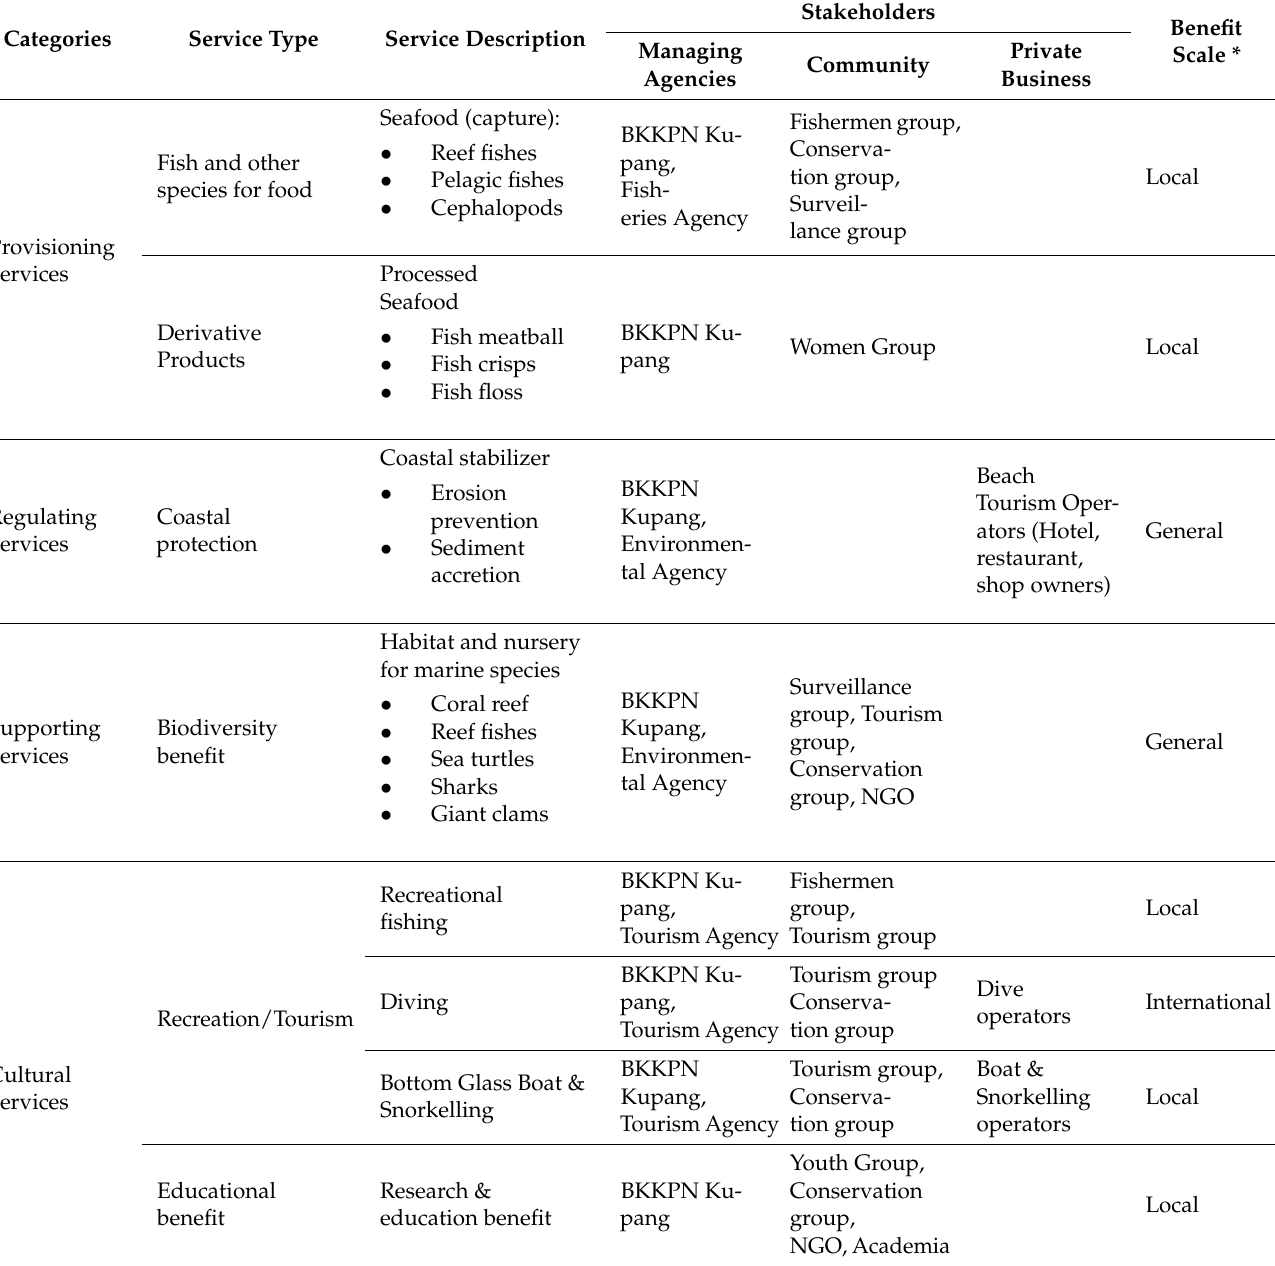
Table 1. The Ecosystem Services and Stakeholders of the coral reef ecosystem within the Gili Matra Marine Tourism